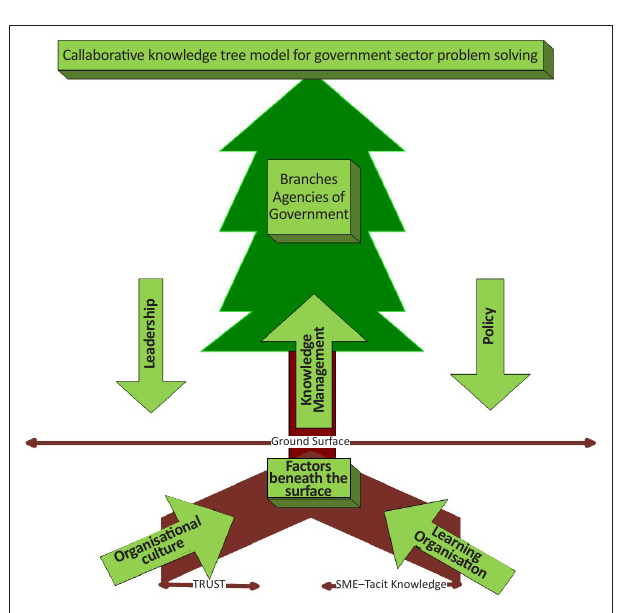
FIGURE 2: Collaborative knowledge tree model for public sector problem solving.